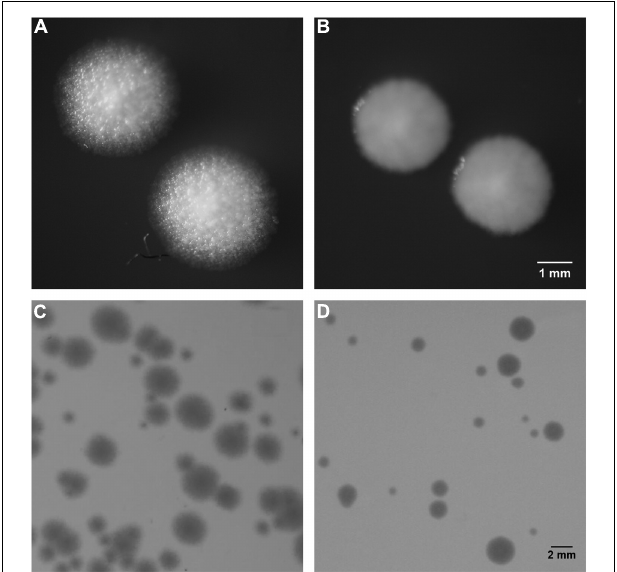
FIGURE 2 | Colony morphology of HF01 and JK09 on MRS agar after anaerobic cultivation. The colonies were photographed after 5 days of incubation. HF01 control (A) , JK09 control (B) , HF01 exposed to PAA (C) , JK09 exposed to PAA (D) . Strain HF01 grows as rough colonies while JK09 grows as smooth colonies. For both HF01 and JK09, the colonies without treatment were uniform in size, in contrast, the colonies after treatment with PAA were varying in size. (A) and (B) were illuminated from above to highlight the surface structure; (C) and (D) were illuminated from below to visualize the size difference of the